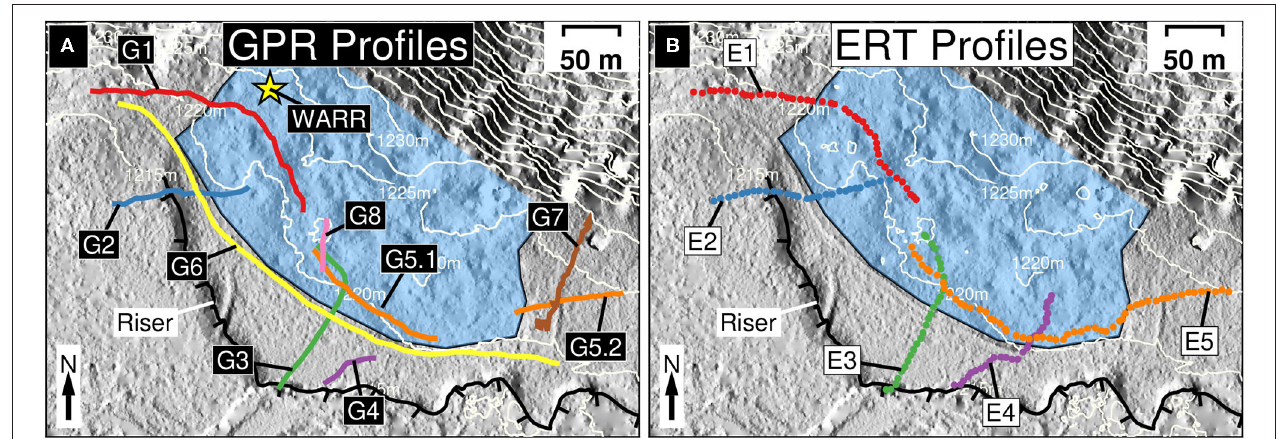
FIGURE 2 | (A) Map view of GPR profiles and WARR location. (B) Map view of ERT profiles. GPR and ERT profiles overlap to allow for joint processing and interpretation.